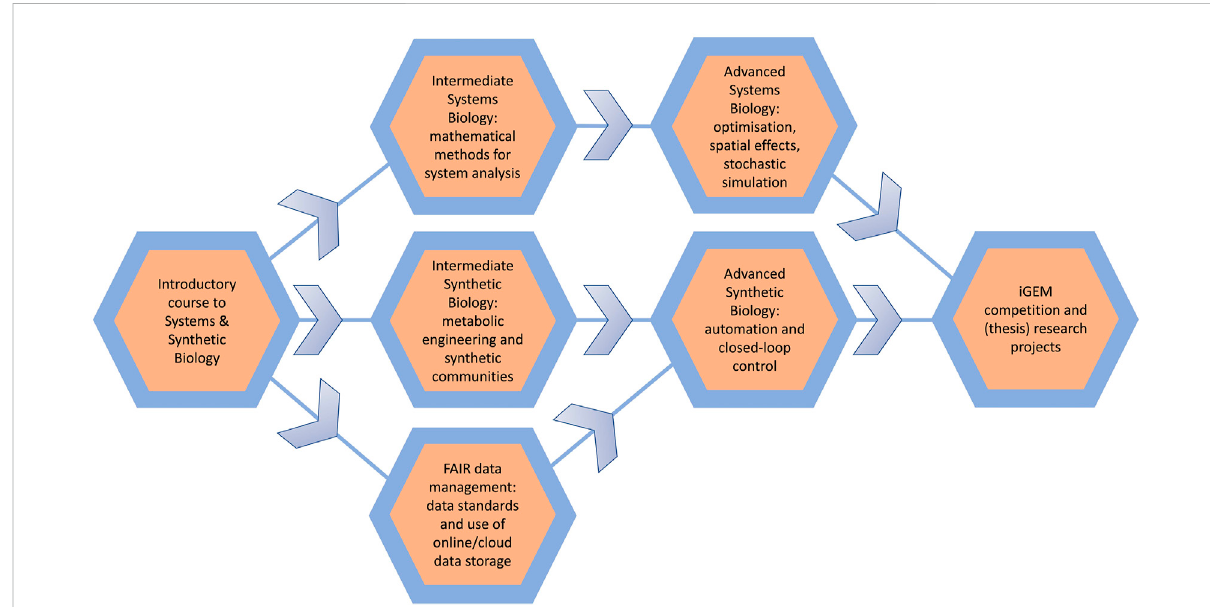
FIGURE 4 An overview of an idealised systems and synthetic biology course curriculum. Starting with the introductory course we have discussed in the main text, students could follow a range of further courses at an intermediate and then advanced level. Through one channel, students can learn more advanced systems biology topics and modelling methods; through a second channel, students could extend their laboratory experience